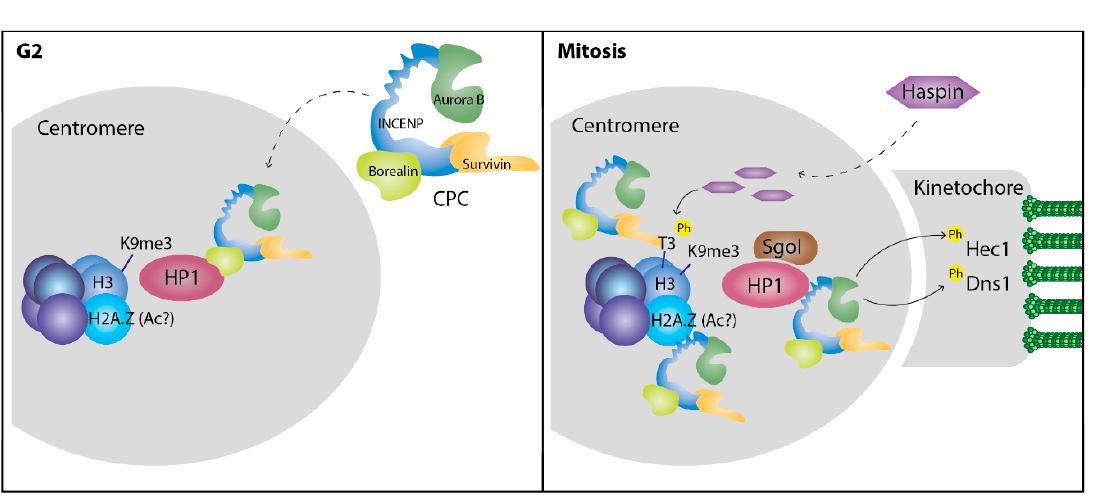
Figure 2. HP1 functions at the centromere. H3K9me3 and H2A.Z—probably the acetylated version (Ac?)—both play a role in maintaining HP1 to the centromeres. Before mitotic entry, HP1 binding to